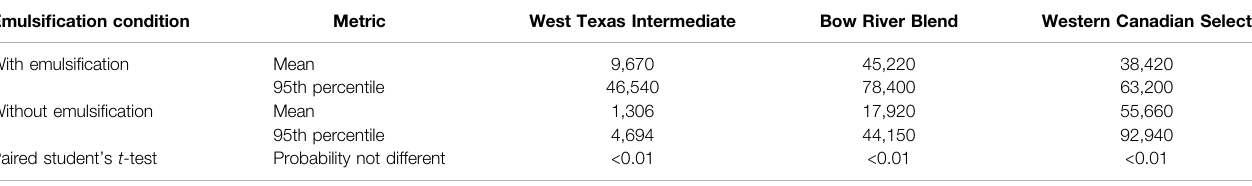
TABLE 4 | Expected surface area (km 2 ) swept by ≥ 0.1 g/m 2 of fl oating oil for a surface release of 200 MT, based on results for 114 simulations varying spill date.